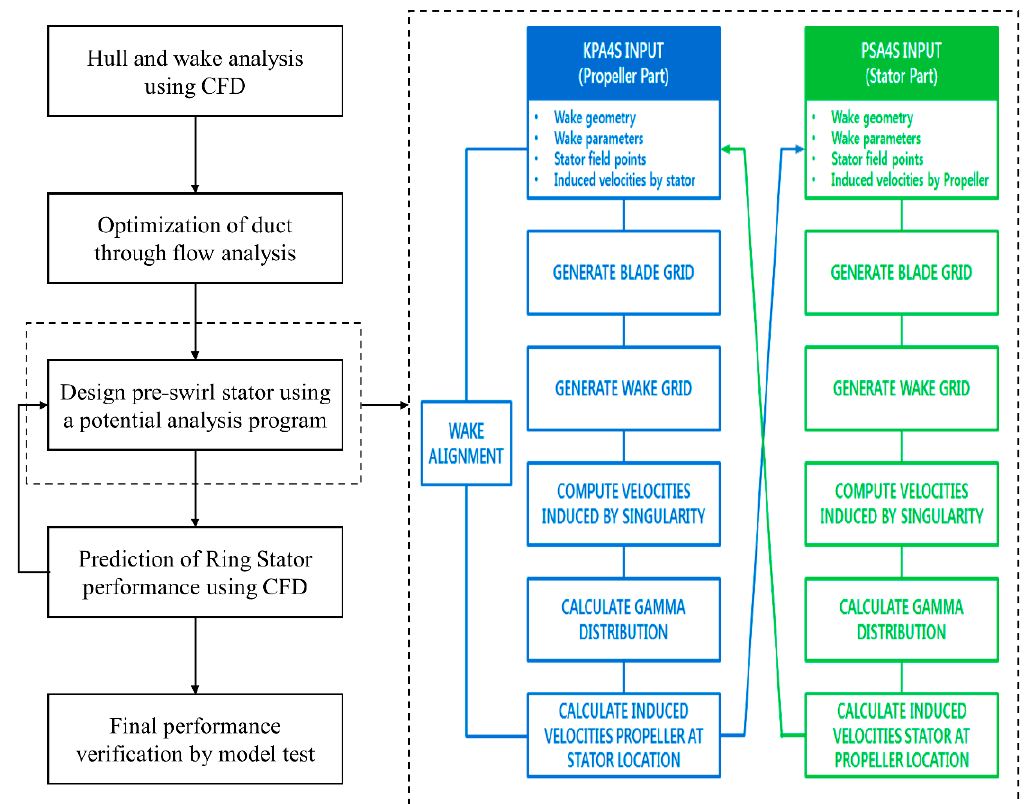
Figure 9. The flow chart of ring stator design.